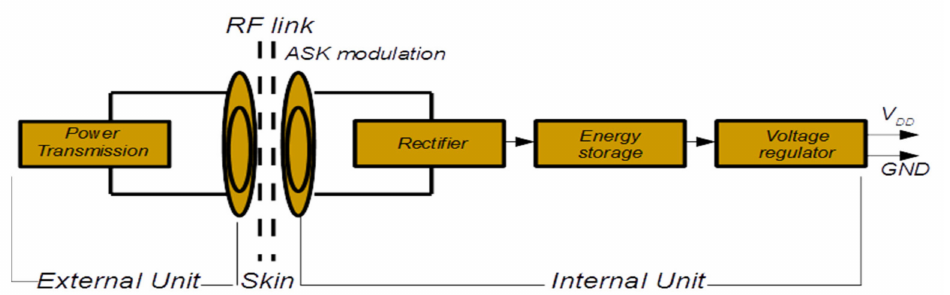
Figure 2. Basic architecture of the cochlear